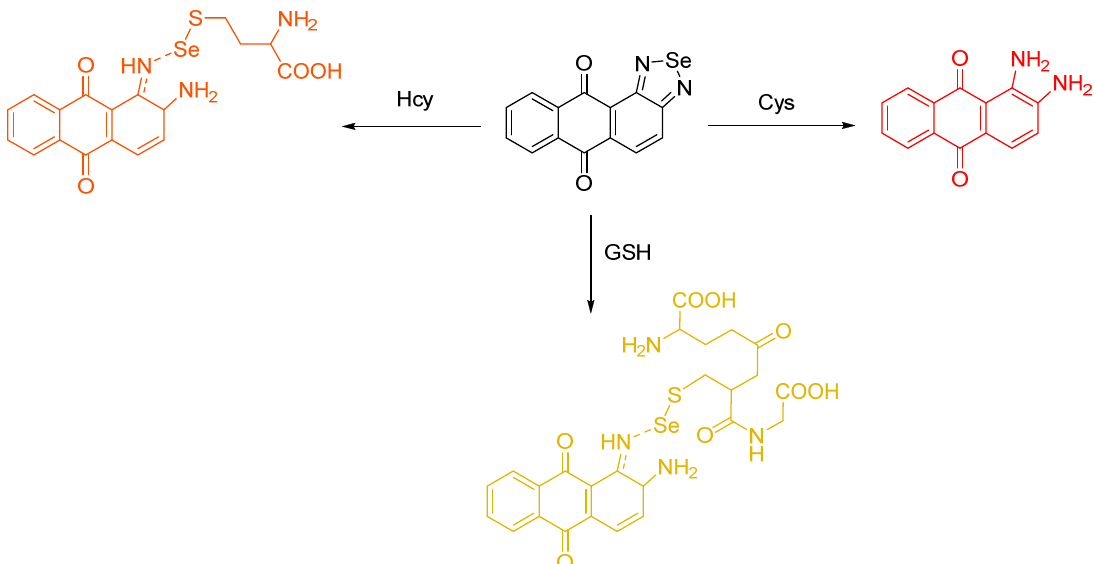
Figure 30. The structures of DAAQ and the proposed mechanism of the probe for differentiating Cys, Hcy, and GSH by Tian et al.